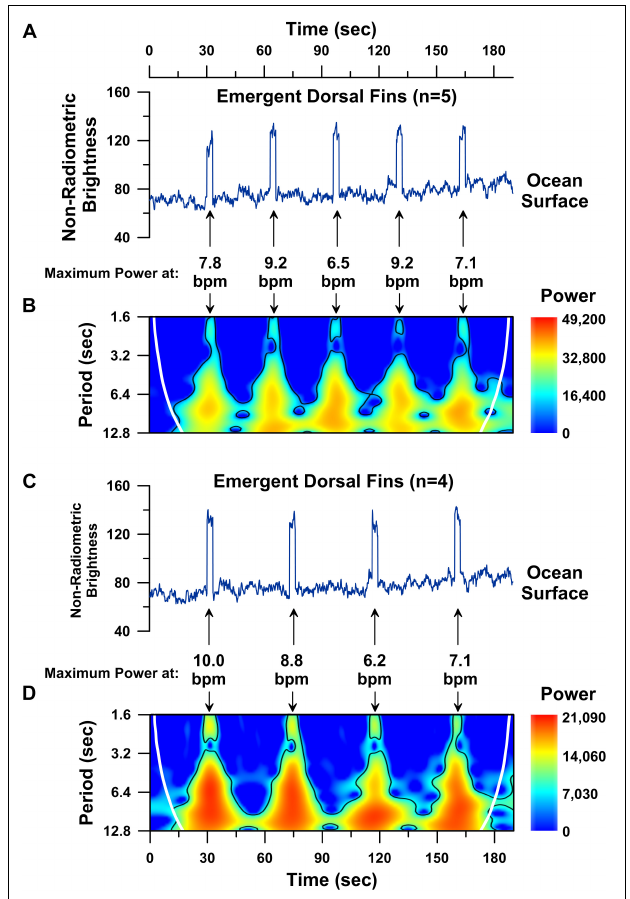
FIGURE 6 | Time series analysis performed on constructed 190 s-long model brightness temperature records for a simulated free-swimming whale. Time series plot of non-radiometric ocean surface water brightness temperatures (blue line; values < 100) followed by 3 s-long dorsal fin hot-spot brightness temperatures (blue line; values > 100) simulating a 5-breath breathing sequence with 30 s separating each breath (A) . Wavelet power spectrum showing significant ( p < 0.05) periodicities (i.e., higher power areas inside the solid black line) present in the modeled 5-breath sequence (B) . Time series plot of non-radiometric ocean surface water brightness temperatures (blue line; values < 100) followed by 3 s-long dorsal fin hot-spot brightness temperatures (blue line; values > 100) simulating a 4-breath breathing sequence with 40 s separating each breath (C) . Wavelet power spectrum showing significant ( p < 0.05) periodicities (i.e., higher power areas inside the solid black line) present in the modeled 4-breath sequence (D) . Cone of influence indicated by white line in B,D